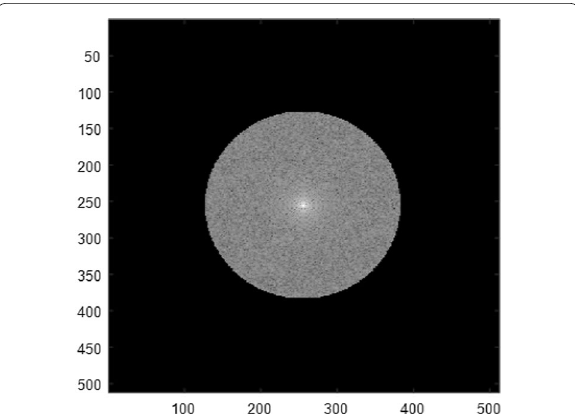
Fig. 6 The modulated speckle pattern shown in Fig. 5 is truncated by the 1st microscope objective. The aperture radius